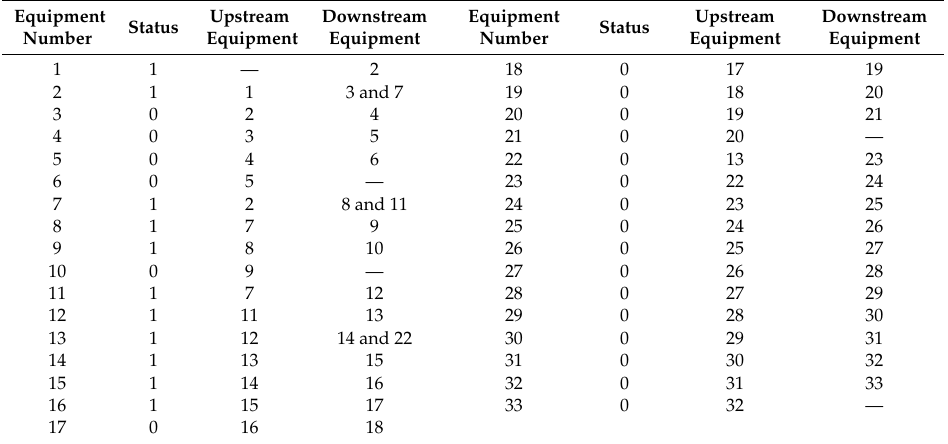
Table 4. The line list of Figure 7.